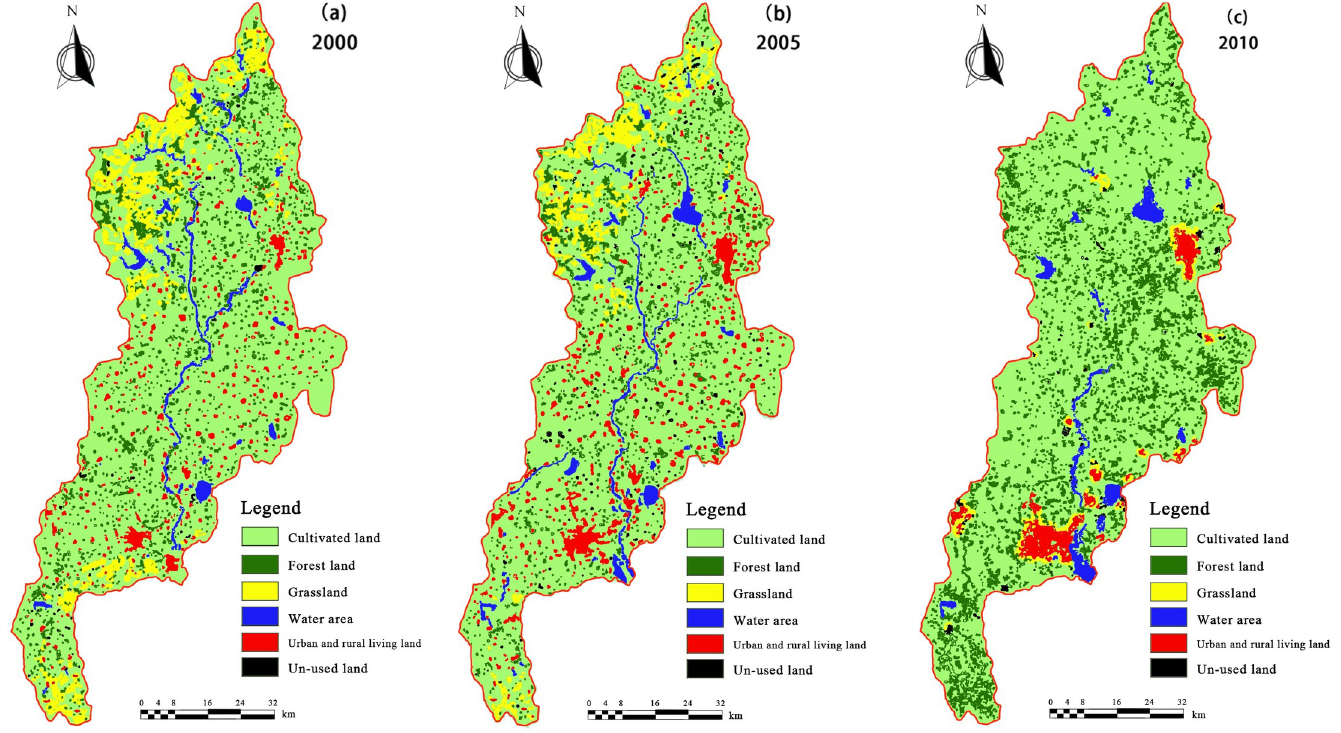
Fig 1. Distribution of land types over